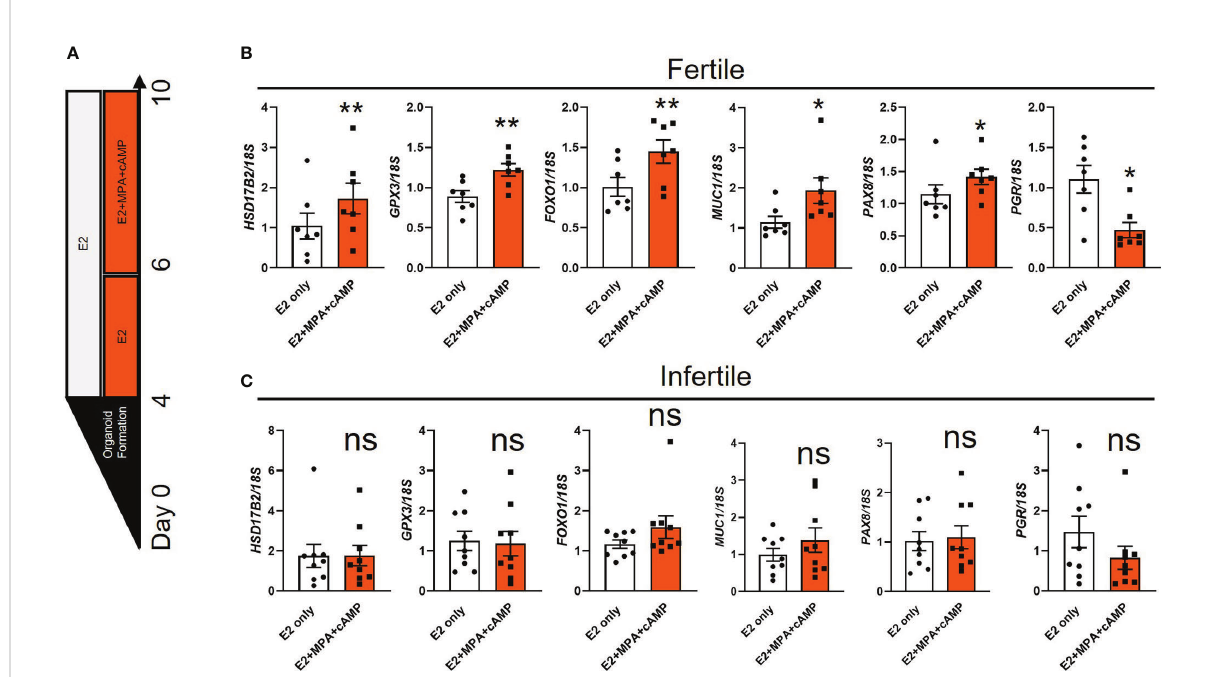
FIGURE 2 The expression of receptivity markers is dysregulated in infertile organoids after hormone treatments. (A) Schematic of hormone treatments for organoids. Passaged fertile and infertile organoids were cultured for 4 days in ExM to reform organoid structure before being subjected to E2 (to mimic proliferative phase) or E2+MPA+cAMP treatment (to mimic receptive phase). (B, C) After hormone treatments, organoid cells were collected for RT-qPCR analysis to determine the expression of receptivity markers. Expression levels were normalized to 18S (n=7-9 biological replicates). All data were presented as mean ± SEM. * P <0.05, ** P <0.01, ns, no signi fi cant